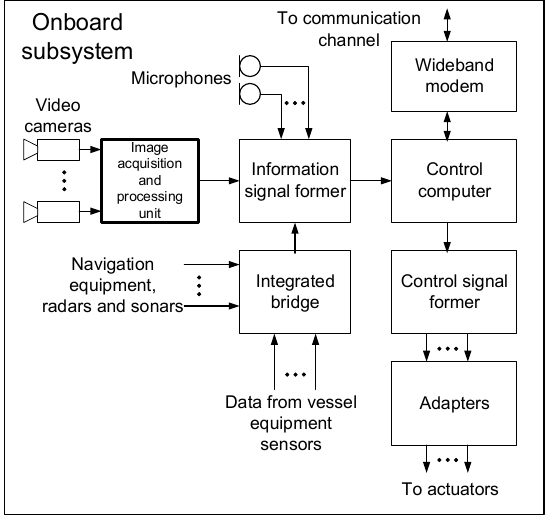
Fig. 1. Block diagram of the onboard subsystem of the remote control system of unmanned vessel . When observing a black object ( R = 0), we obtain